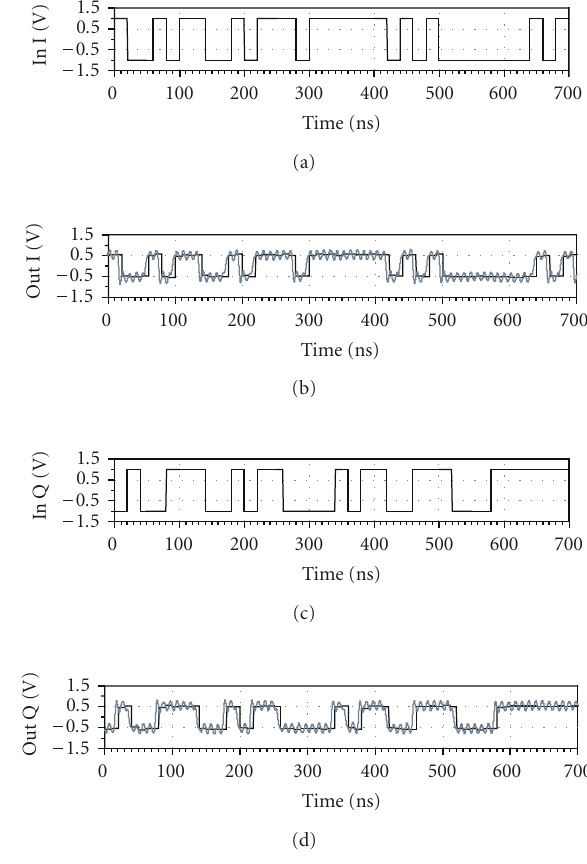
Figure 12: Demodulation results of 100Mb/s QPSK pseudoran- dom bit